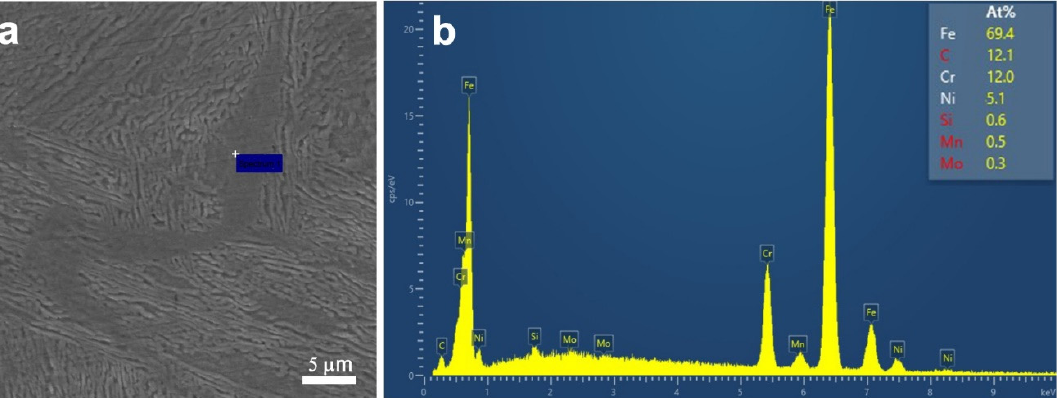
Figure 2. ( a ) SEM images of the reticular phase on the weld fusion line. ( b ) EDS spectrum at the location indicated by the cross symbol in ( a ).